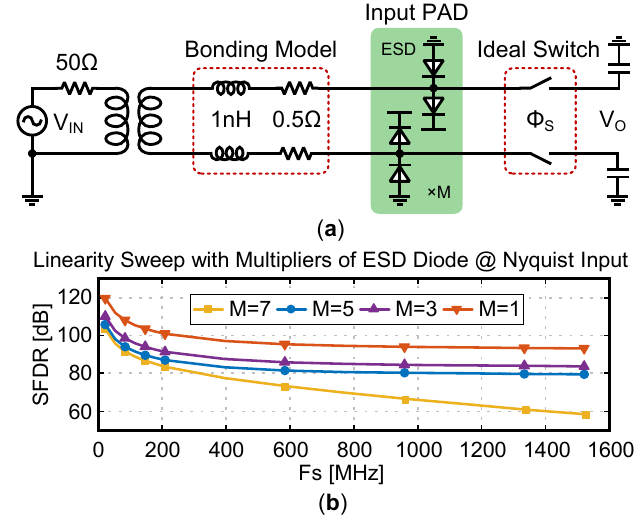
Figure 3. High linearity modified input pad and simulated result: ( a ) The simulation setup to evaluate the linearity of the front-end considering the parasitic model of packaging and ESD diodes; ( b ) The simulation results of linearity versus multipliers of ESD diodes.